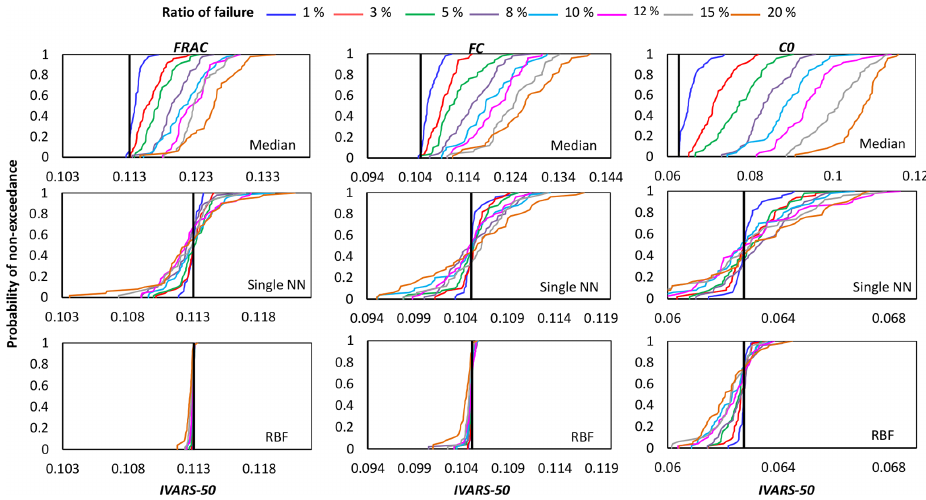
Figure 4. Comparison of the proposed crash-handling strategies in a sensitivity analysis of the HBV-SASK model using the STAR-VARS algorithm for different ratios of failure. The CDFs of the sensitivity indices for strongly influential parameters { FRAC , FC , C0 } are compared in this plot. The vertical line (solid black) on each subplot represents the corresponding “true” sensitivity index obtained when there were no failures.